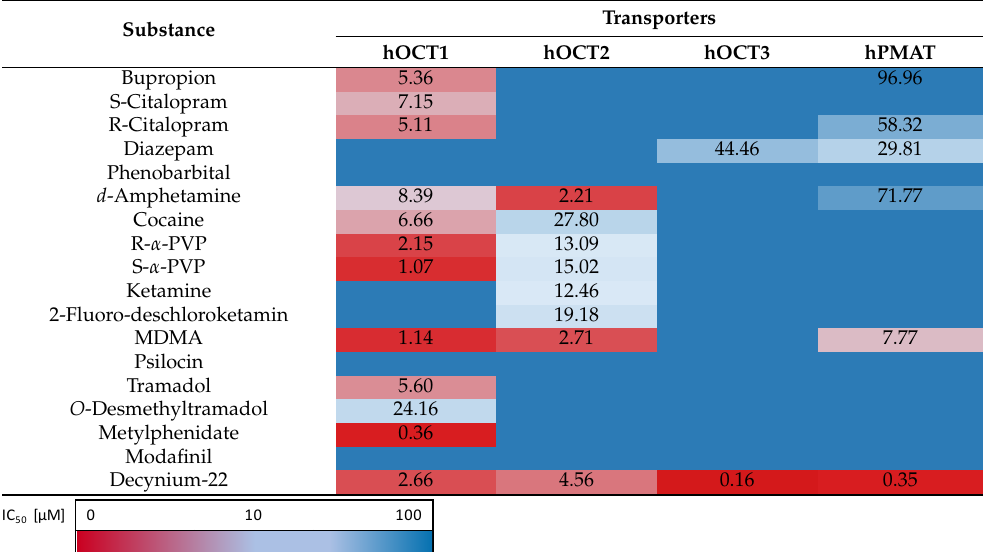
Table 1. Heat map portraying the inhibitory potency (in µ M) of screened compounds at hOCT1–3 and hPMAT. Lower values are highlighted in red and higher in shades of blue (see